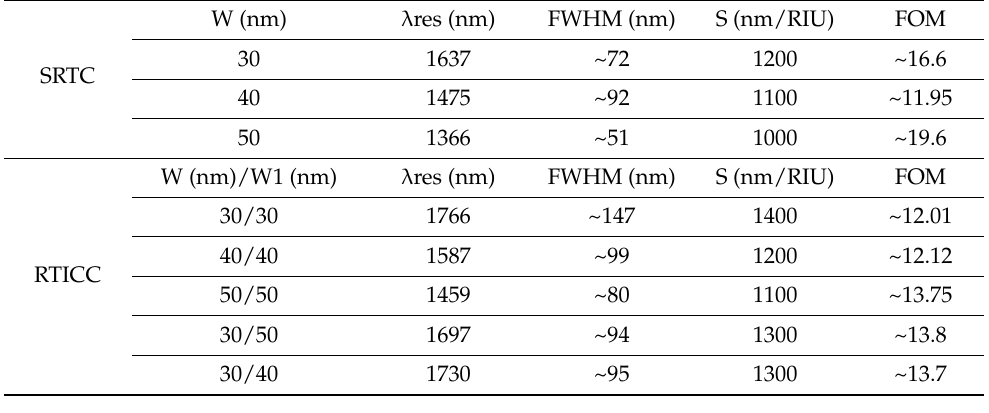
Table 2. Spectral characteristics of SRTC and RTICC for ∆ n = 0.01.